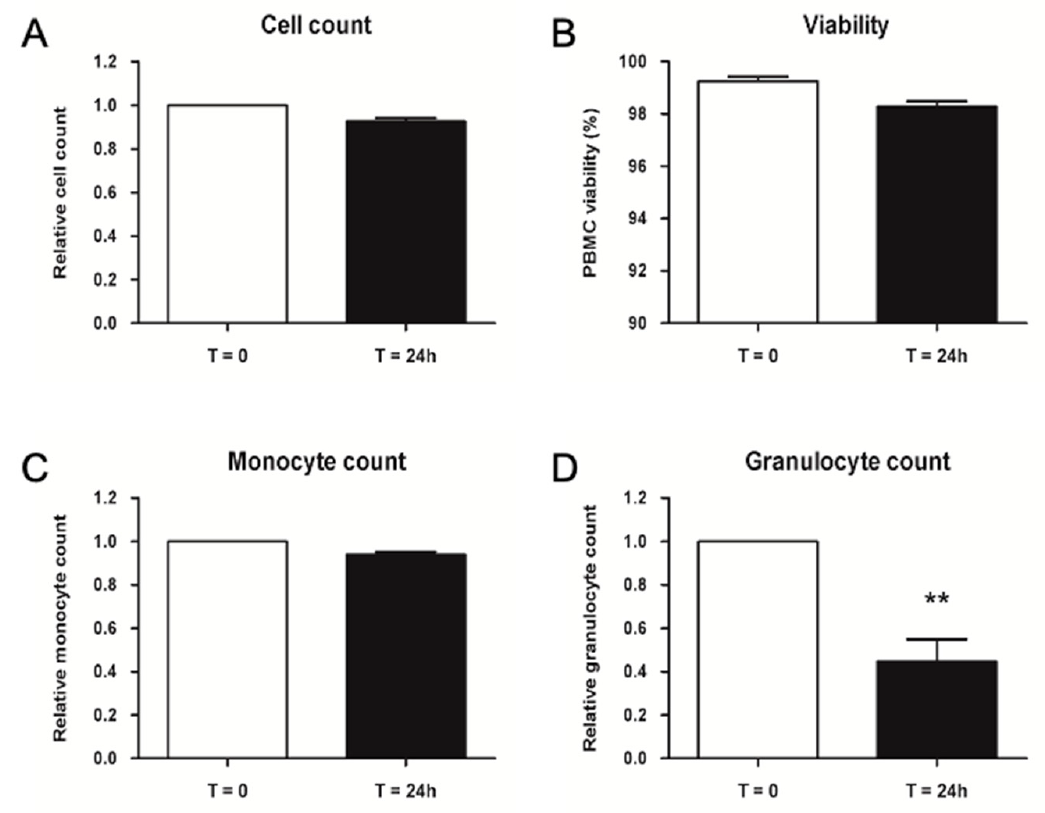
Figure 8. Validation of PBMC storage at 4 ± 2 °C for 24 h. ( A ) Relative cell count, ( B ) viability percentage, ( C ) relative monocyte and ( D ) granulocyte count of thawed PBMC at T = 0 and T = 24 h. Relative values are normalized to control samples at T = 0. Data are represented ad mean ± SEM, N = 3. ** = p < 0.01.